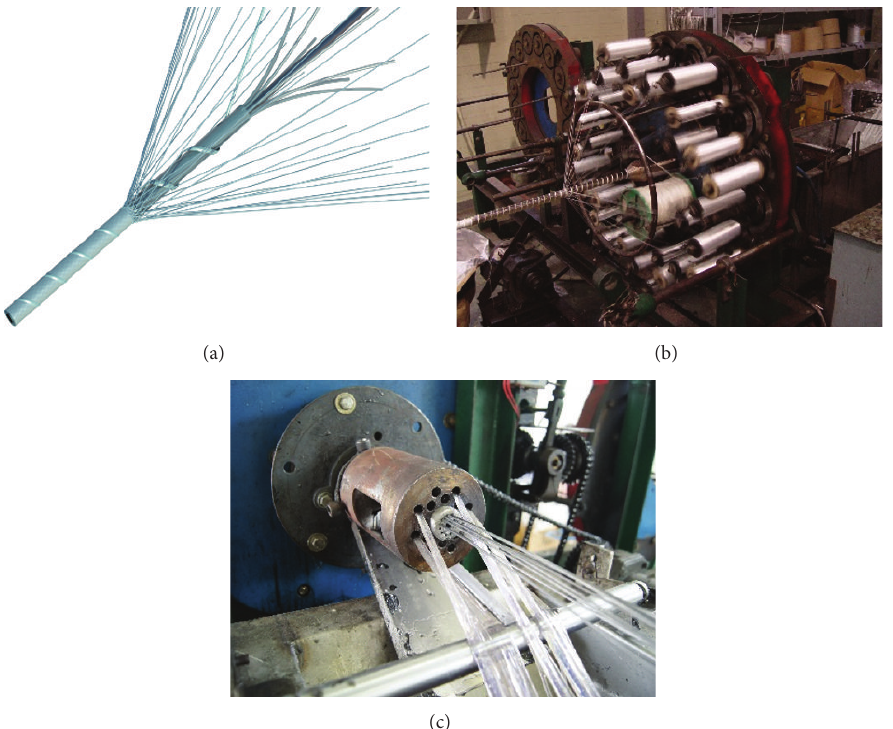
Figure 5: The braidtrusion process [24]: (a) the conceptual configuration; (b) the braidtrusion machine; and (c) the insertion of steel wires.